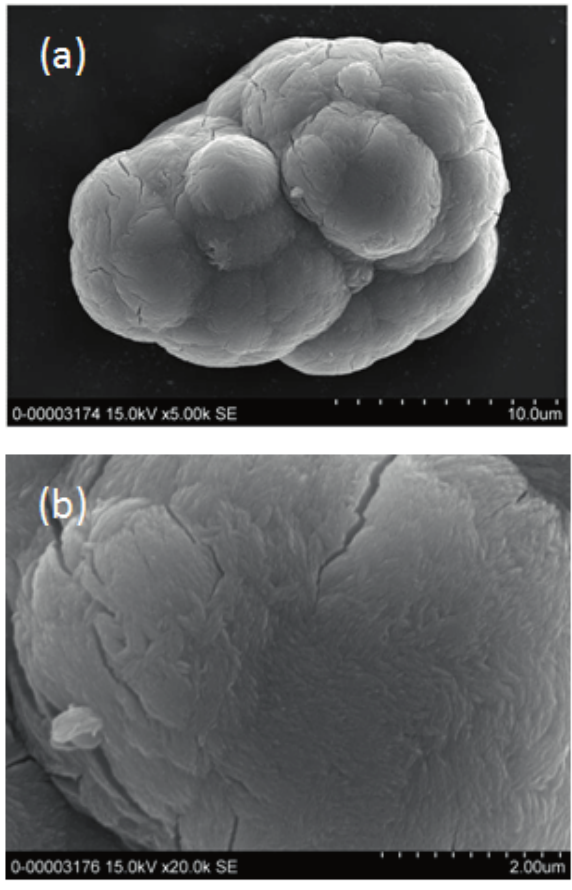
Figure 1. SEM images of solid particles coprecipitated by oxygen injection, observed at (a) low magnification and (b) high magnification.